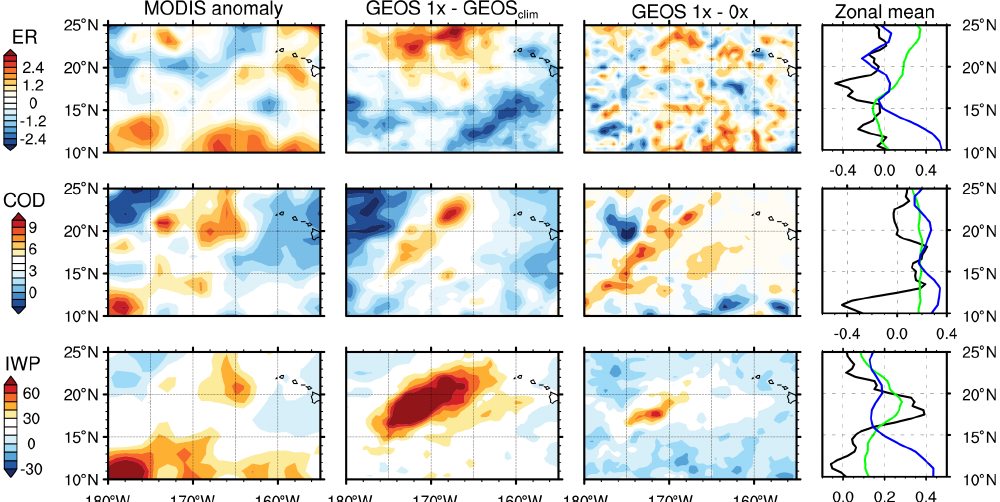
Figure 9. Like Fig. 8 but for MJJ